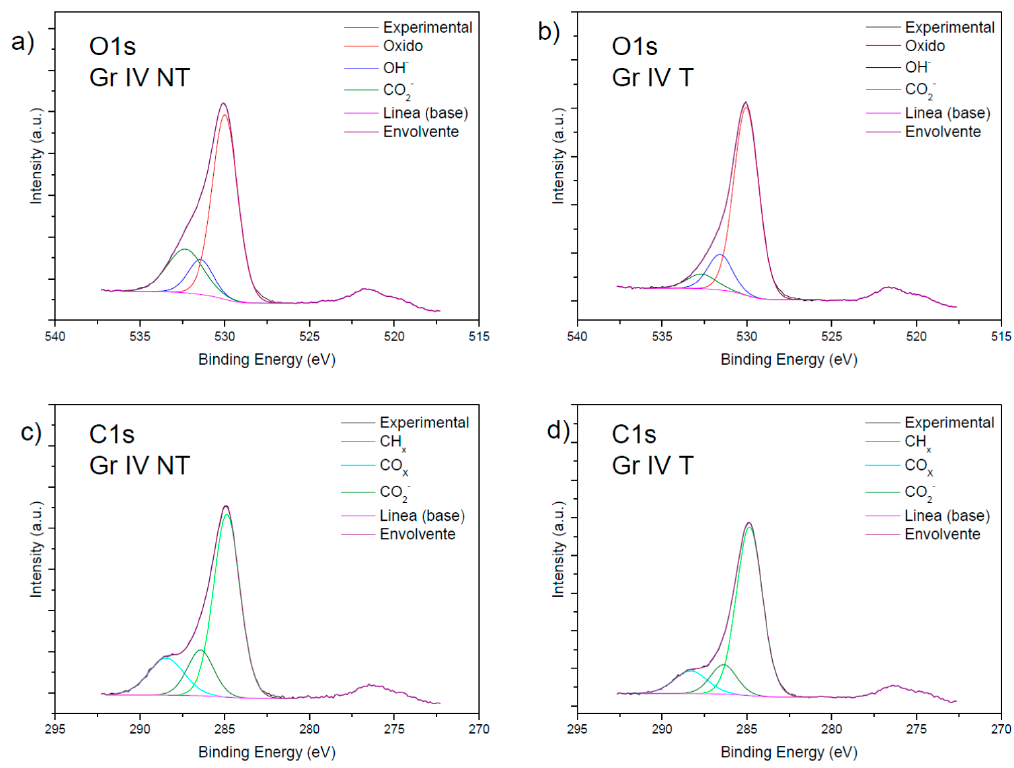
Figure 3. O 1s X-ray photoelectron spectroscopy (XPS) spectra of the untreated grade IV ( a ) and the treated grade IV surfaces ( b ). C1s spectra of the untreated grade IV ( c ), and the treated grade IV ( d ) surfaces. (GR IV: Titanium grade IV; GR V: Titanium grade V; T: SLA treated; NT: SLA